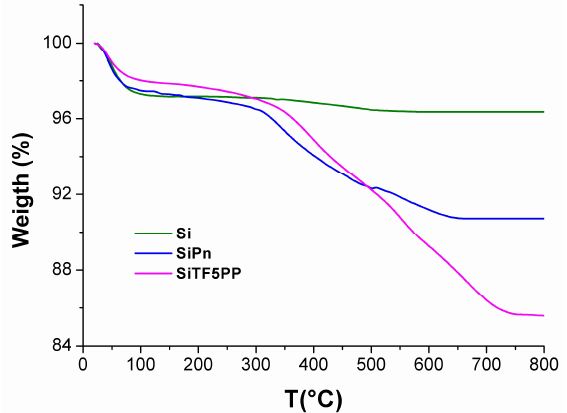
Figure 2. Thermogravimetric curves of Si , SiPn and SiTF 5 PP .